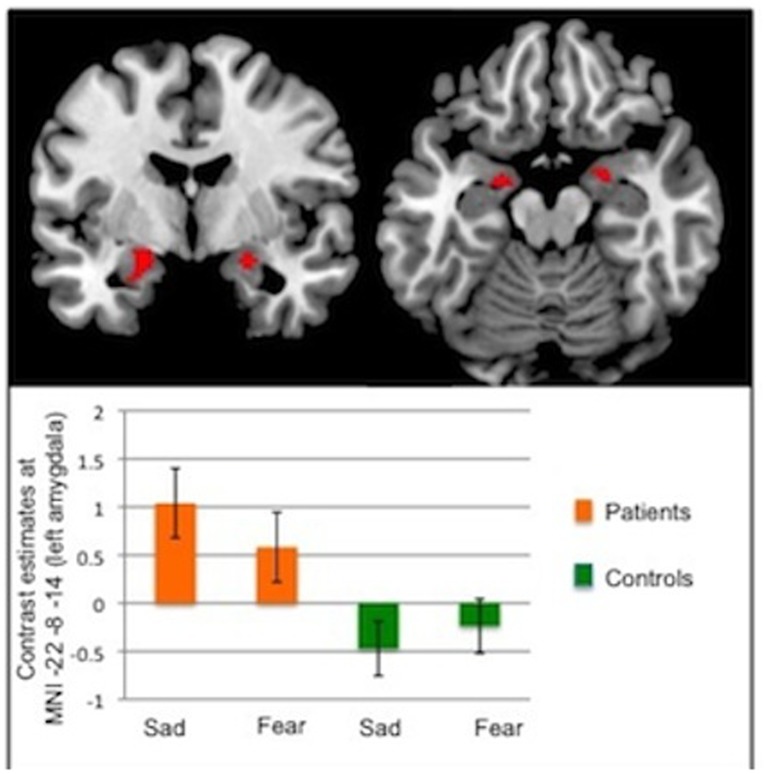
ROI analysis: Group effect in the Emotion Model.
Upper panel: Activation in the amygdalae in response to emotional faces showing a group effect (CD patents > healthy controls). Statistical maps have been thresholded at p<0.005 uncorrected for display purposes. A significant increased activity was found in the left amygdala (FWEp = 0.027, z = 3.3, [–22–8–14]). Of note, the right amygdala activation displayed here did not reach conventional levels of significance after correction for multiple comparisons (FWE p = 0.078 at MNI [22–4–14]). Lower panel: Graph showing contrast estimates for left amygdala activation in response to each negative emotion (sad, fear) separately for the 2 groups: CD patients (in orange) and healthy controls (in green).